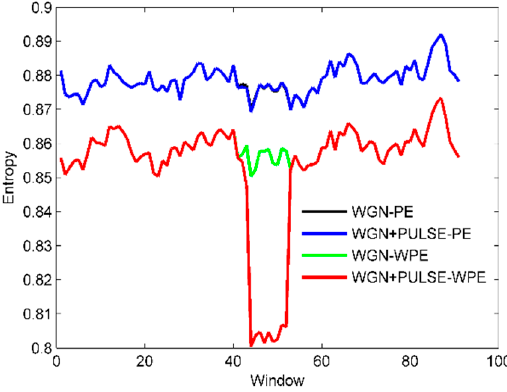
Figure 6. The curve of PE and WPE with window.